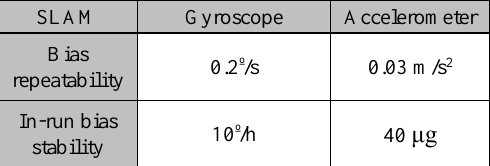
Figure 2. An exemplary representation of the prediction and adjustment processes within SLAM.